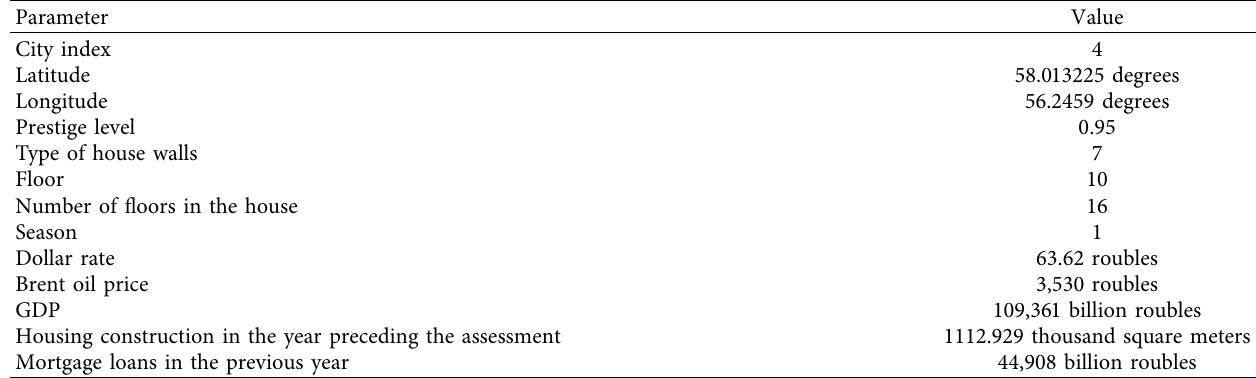
Table 5: Input parameters of the model that characterize a house in Perm, its geographical location, evaluation time, and the corresponding economic situation in the world, country, and region.